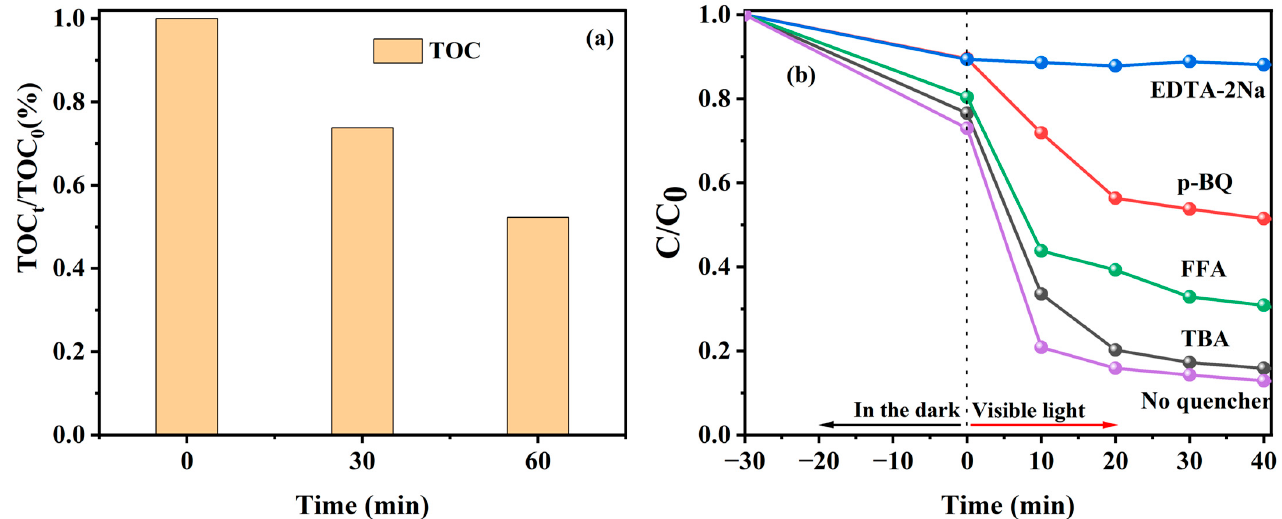
Figure 10. TOC changes in TC by 9%Co-CNK-OH under visible light ( a ); photo-Fenton degradation e ffi ciencies of TC by 9%Co-CNK-OH with di ff erent scavengers under visible light ( b ). To fi gure out the mechanism of TC degradation by 9%Co-CNK-OH, TBA, EDTA- 2Na, p-BQ, and FFA were used to capture ·OH, h + , ·O 2 − and 1 O 2, respectively (Figure 10b). Compared with the e ffi ciency of TC removal (87.10%) by 9%Co-CNK-OH without any trapping-agent addition, the e ffi ciency of TC degradation was reduced by 2.95%, 75.25%, 38.60%, and 17.98% with the addition of TBA, EDTA-2Na, p-BQ, and FFA, respectively, suggesting that h + , ·O 2 − , and 1 O 2 are the main active species for the photocatalytically as- sisted Fenton-like degradation of TC by Co-CNK-OH.